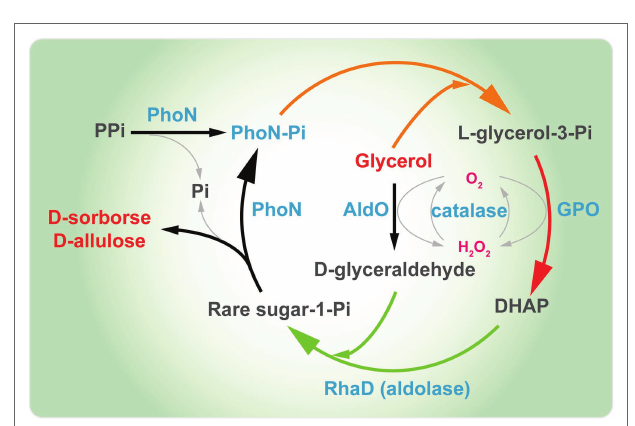
FIGURE 8 | Multienzyme synthesis of D-sorbose and D-allulose from glycerol. PhoN, acid phosphatase; GPO, glycerol oxidase; AldO; alditol oxidase; RhaD, L-rhamnulose-1-phosphate aldolase; DHAP, dihydroxyacetone